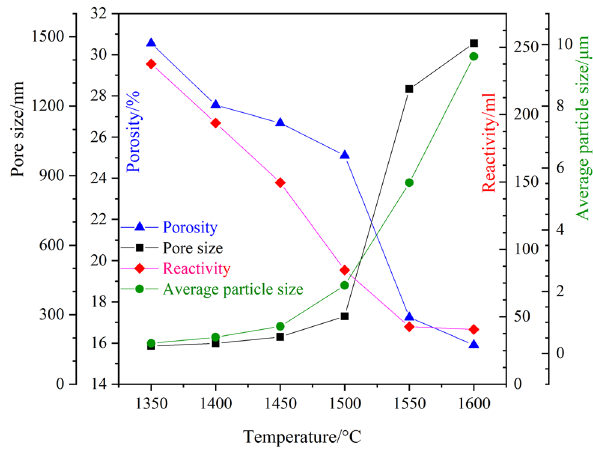
Figure 6: E ff ect of temperature on properties of the heat - treated lime